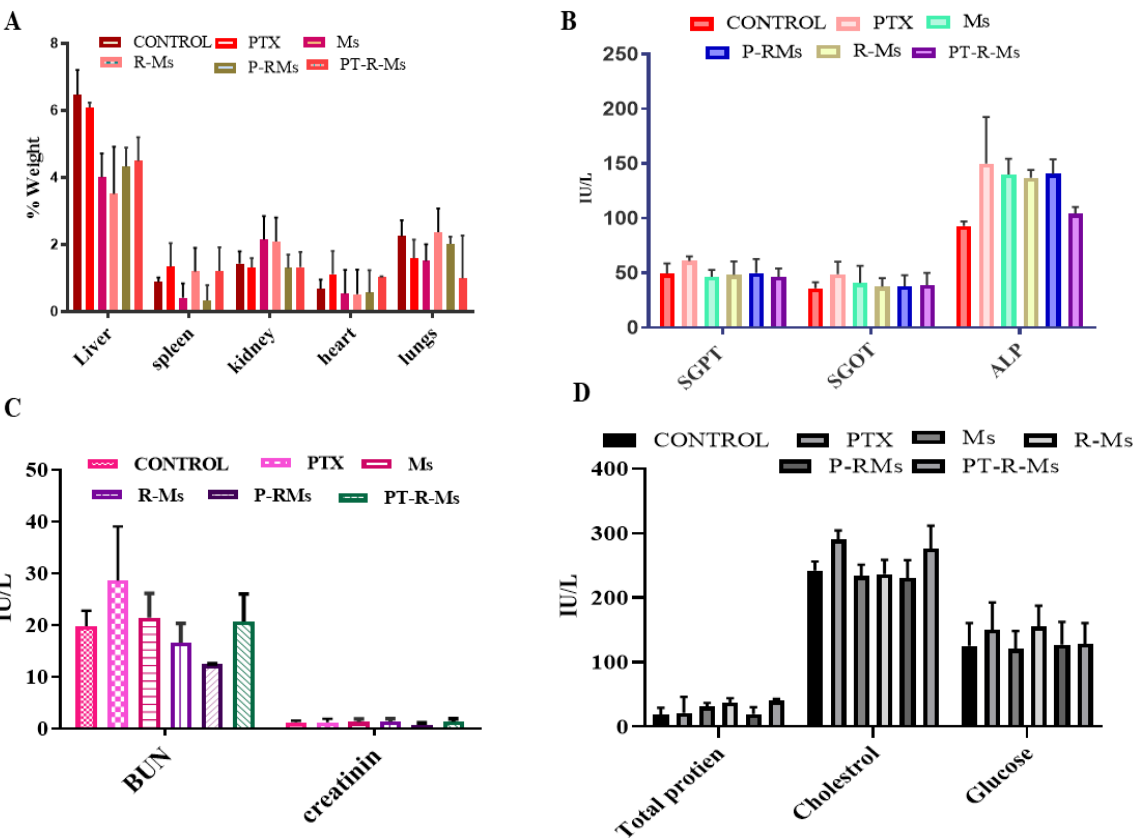
Figure 13. Serum biochemistry analysis of mice plasma after acute oral treatment with PTX, Ms, R-Ms, P-R-Ms, and PT-R-Ms with control to monitor changes on ( A ) body weight % ( B ) LFTs; ( C ) electrolytes; ( D ) total protein, cholesterol, and glucose content. Results are shown as mean ± SD ( n = 3).